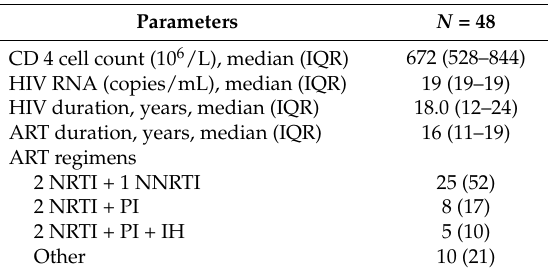
Table 2. HIV related data.